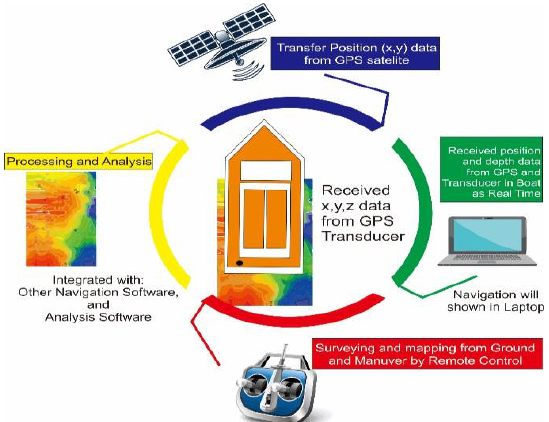
Figure 11. Surveying procedure using ROV boat.